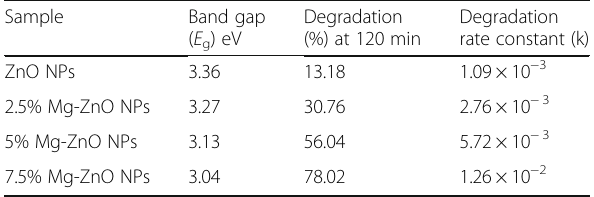
Table 2 Catalytic degradation with band gap energy:(pure and Mg-doped ZnO NPs)